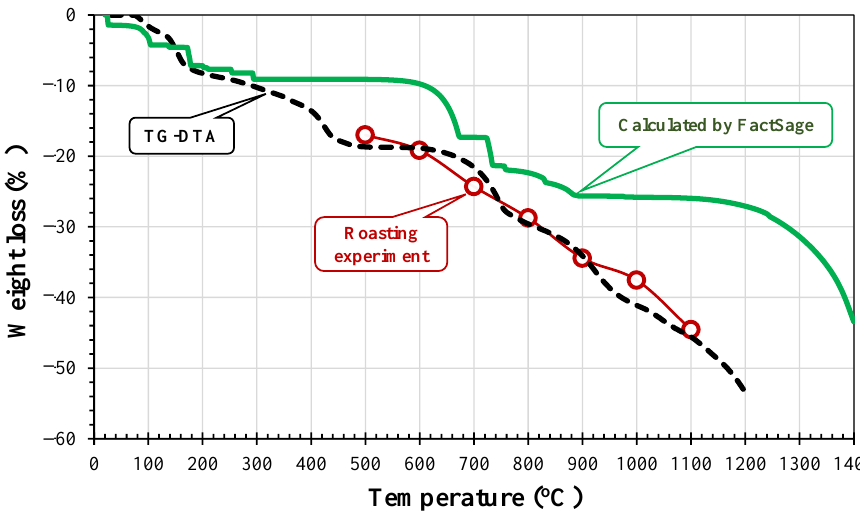
Figure 5. Weight losses versus temperature from roasting experiments, TG/DTA data, and thermo- chemical calculations by FactSage.